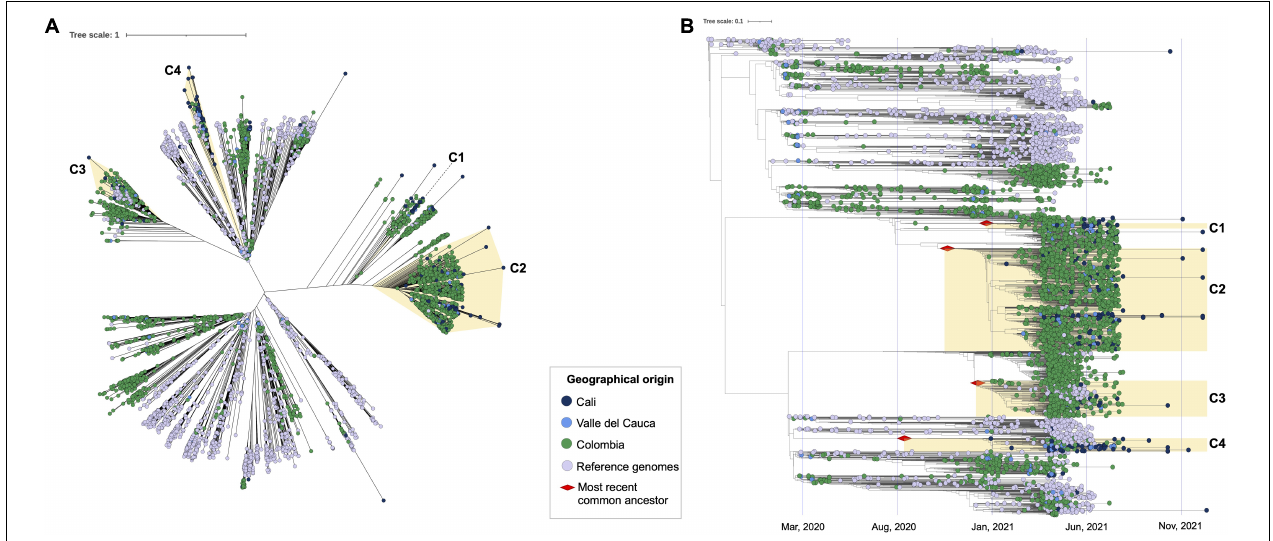
FIGURE 3 | Phylogenomic relationships of evaluated SARS-CoV-2 genomes in the global context, identification of the most recent common ancestor (tMRCA). (A) Phylogenomic relationships between the 5,283 genome sequences analyzed, which included 228 sequences from Cali (blue dots) 3,270 sequences from other areas of Colombia [green dots, including Valle del Cauca (magenta dots)]; and 1,785 reference genomes (purple dots). The clusters consisting of 179 of the 228 genomes from Cali are highlighted in light yellow (C1–C4). (B) Phylogenomic relationships between the 5,283 genome sequences analyzed with the identification of the most recent common ancestor (tMRCA). The red diamond represents the putative introduction date per each cluster.